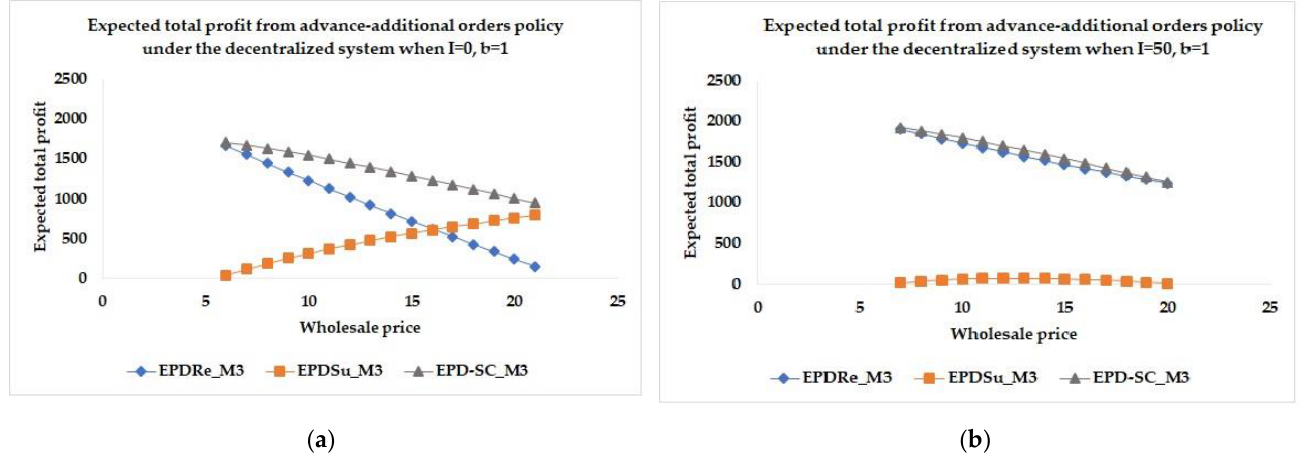
Figure 8. The expected total profit of the retailer, the supplier, and the supply chain of advance-additional orders policy under the decentralized system with different values of w , where b = 1 and ( a ) I 0 = 0; ( b ) I 0 =